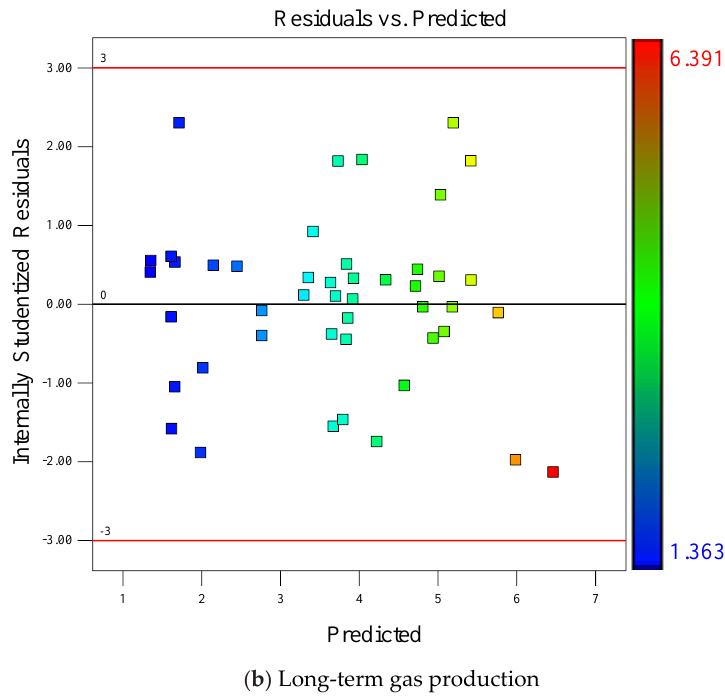
( b ) Long-term gas production Figure 10. The Studentized residuals and predicted responses at different production periods.